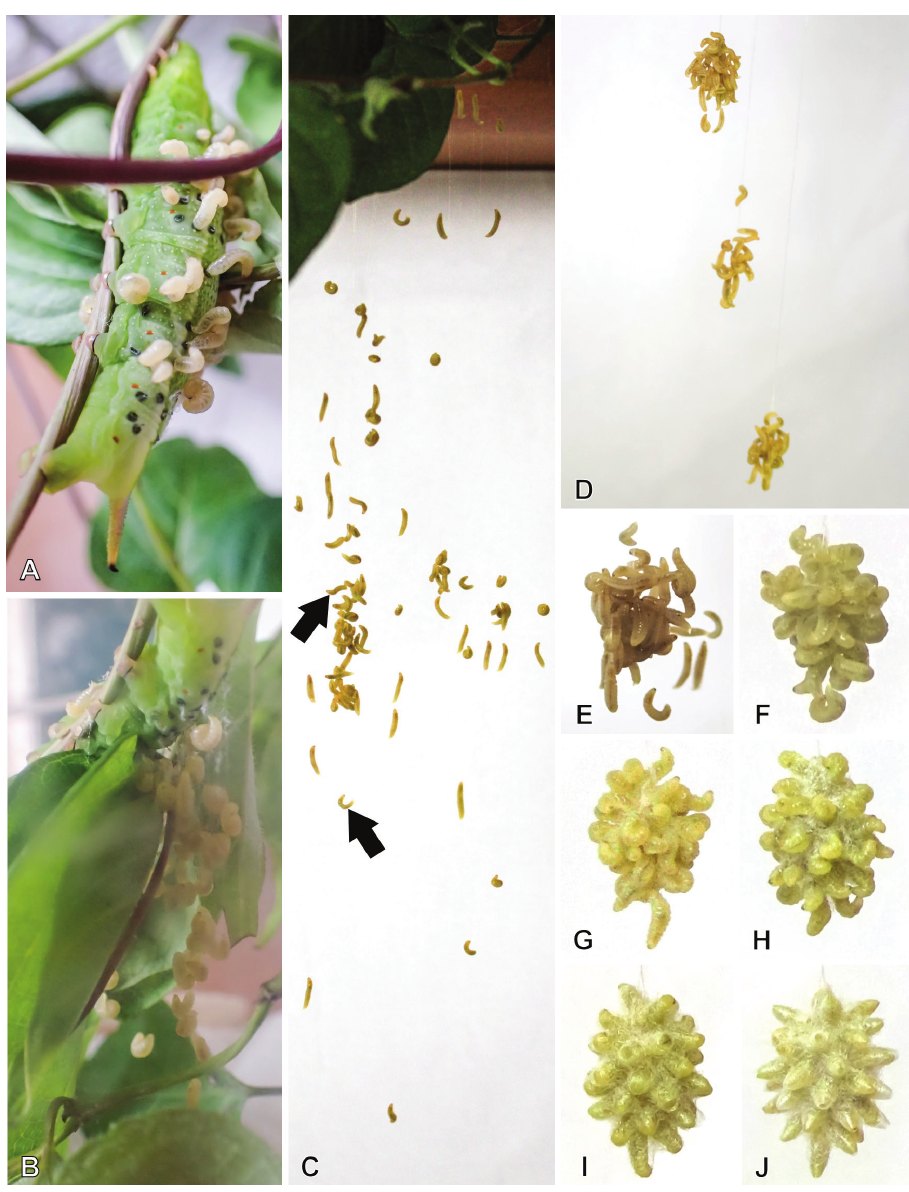
Figure 7. Cocoon forming behavior of Meteorus stellatus sp. nov. A emerging from a host larva (start time) B hanging down from the host plant substance (2 min) C intertwining with threads: arrows show larvae looking for other threads (39 min) D almost merging into three masses (57 min) E–J forming spherical cocoon masses ( E 30 min F 65 min G 69 min H 84 min I 105 min J 139 min). Characteristics of the cocoon masses. The cocoon masses of M. stellatus sp. nov. (Fig. 8) were light brown to brown, 7–14 mm in width, 9–23 mm in length, and regu- larly spherical to ovoid with minimally 12 (Fig. 8D) to maximally over 100